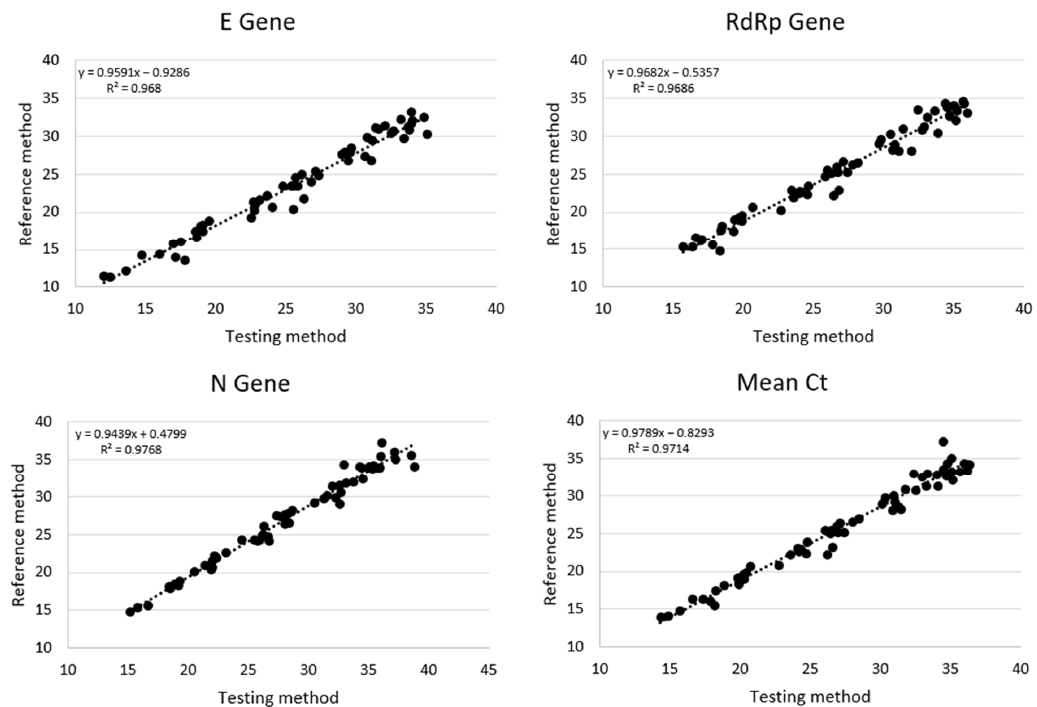
Figure 3. Cycle Threshold correlation between Reference method and Testing method.